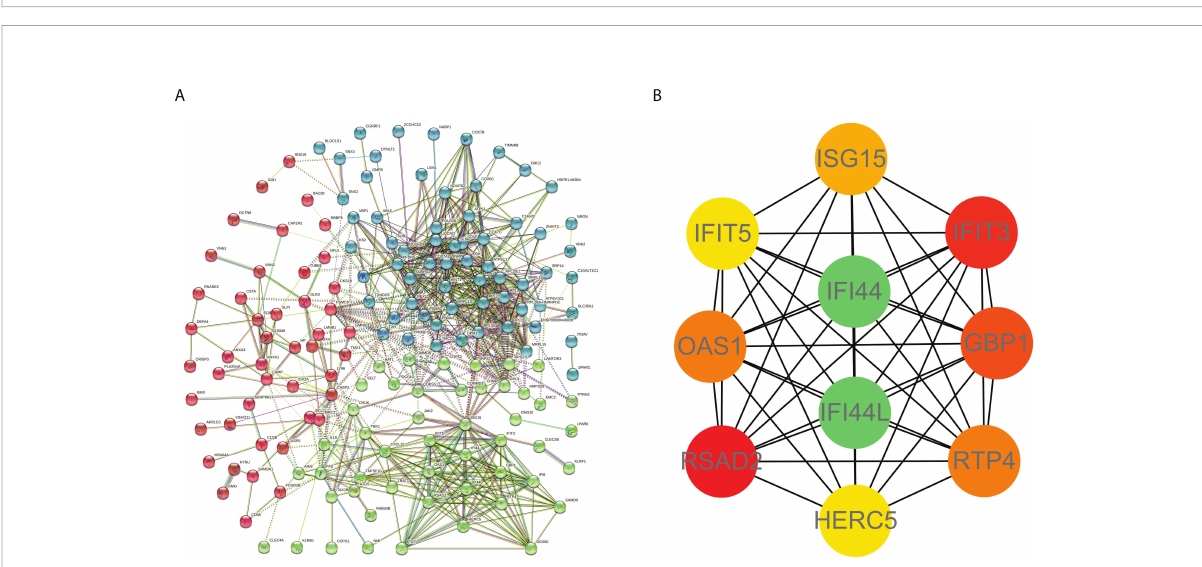
FIGURE 6 PPI interworking networks. (A) PPI network with 184 nodes and 750 edges. The green hexagon in the lower right corner is the top 10 hub genes derived using the CytoHubba analysis method. (B) Analysis of the top 10 hub genes with CytoHubba of